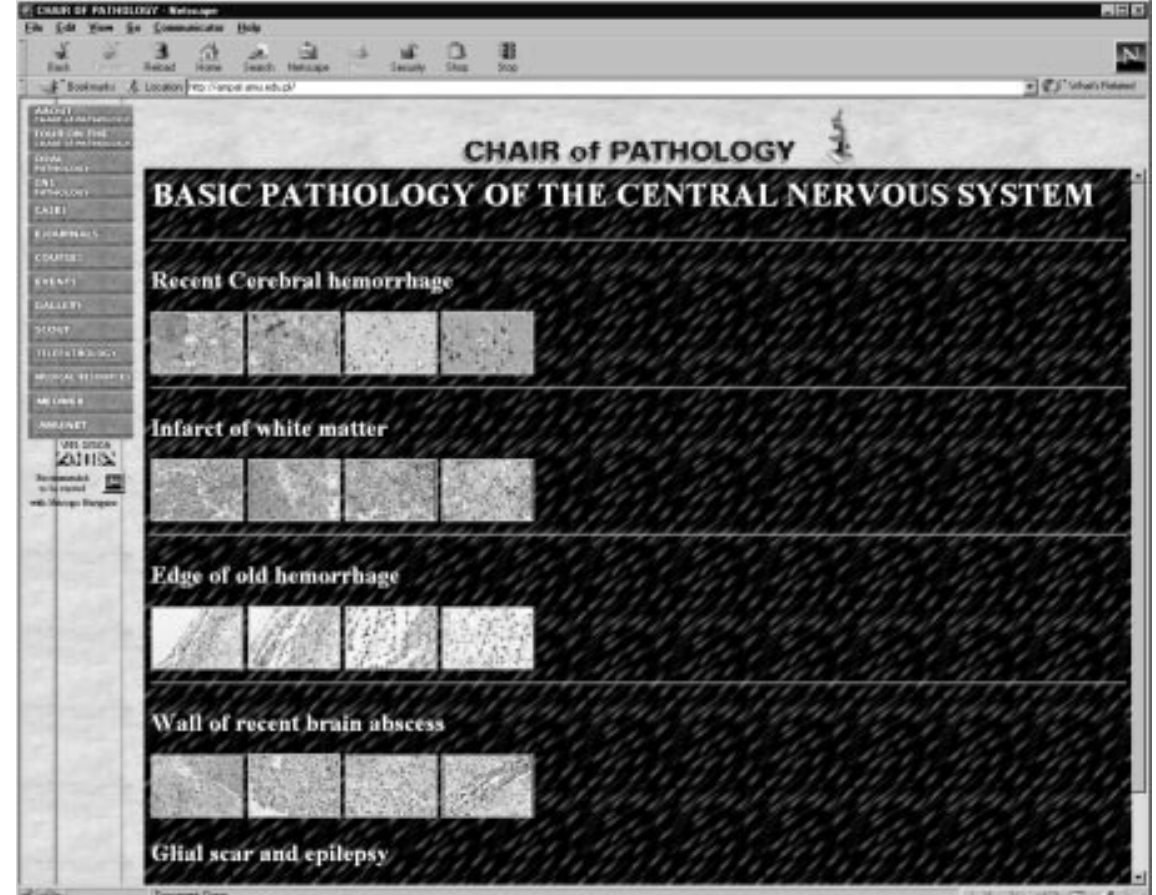
Fig. 3. Gallery of microscopic pictures of basic pathology of the central nervous system at the WWW